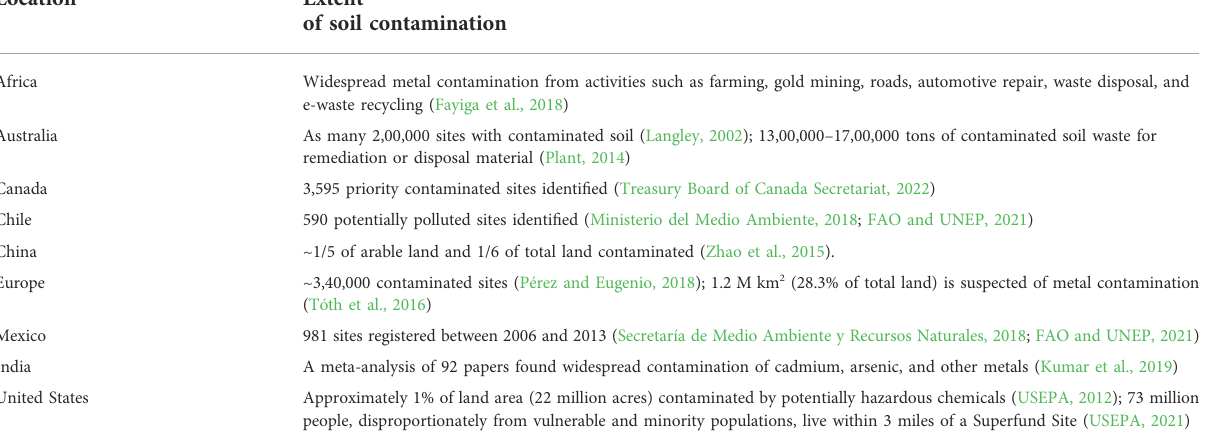
TABLE 1 Examples illustrating the extent of soil contamination in broad geographic areas. Location Extent of soil